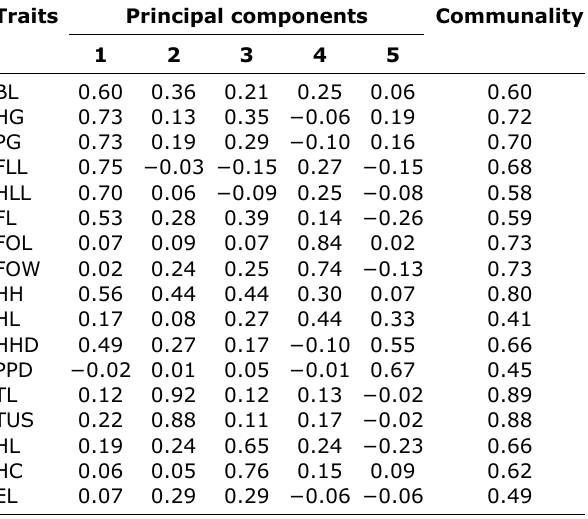
Table-3: Varimax rotated loading matrix and communality estimate for different biometric traits of hill cattle. Traits